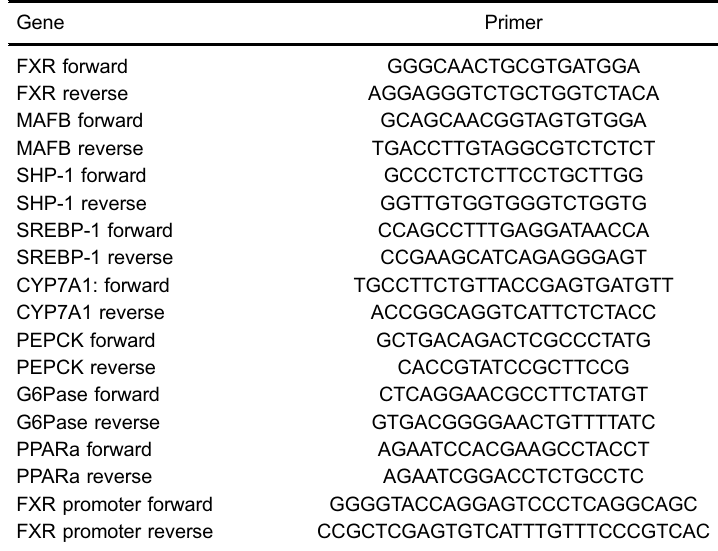
Table 1 . qPCR primers used in the